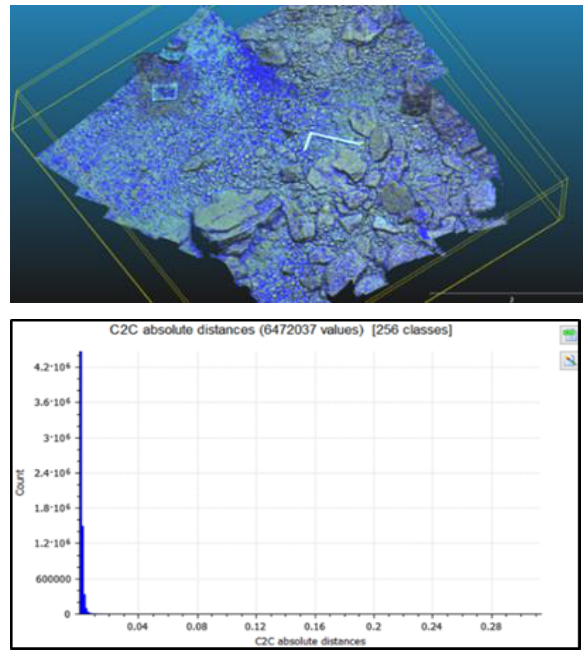
Figure 7. Optical (a) and graphical (b) representation of the difference between the two dense clouds